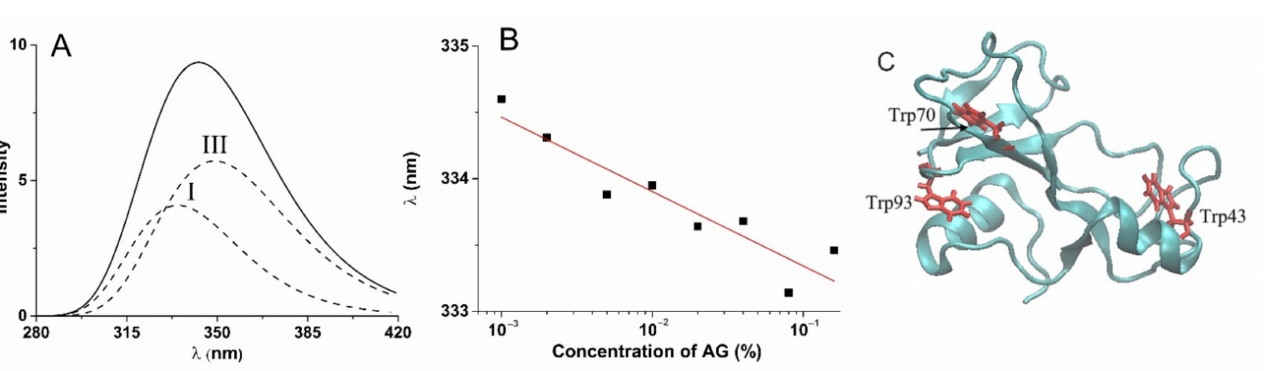
Figure 3. Decomposition of tryptophan fluorescence spectra of binase in alginate hydrogel by two components centered at 334.8 (tryptophan class I) nm and 349.0 nm (tryptophan class III) ( A ); the shift of the tryptophan class I maximum in dependence from alginate concentration ( B ); and binase tertiary structure showing location of three tryptophan residues ( C ).